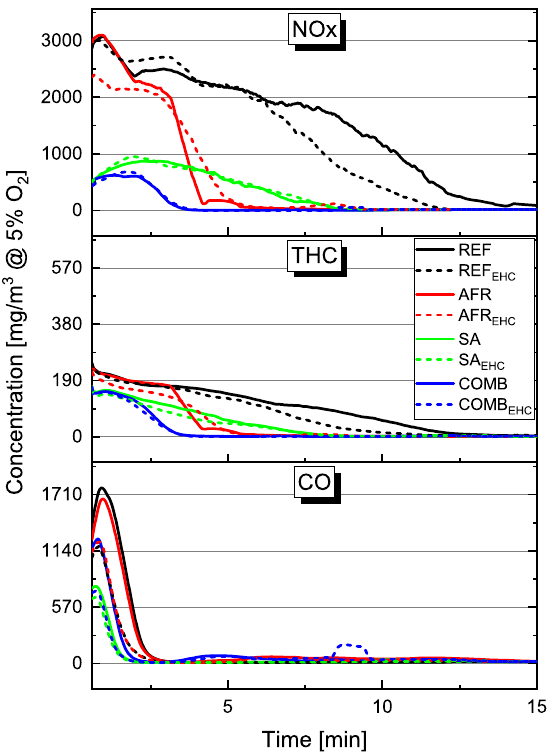
Figure 7. Pollutant concentration with respect to time for first 15 min of a cold-start